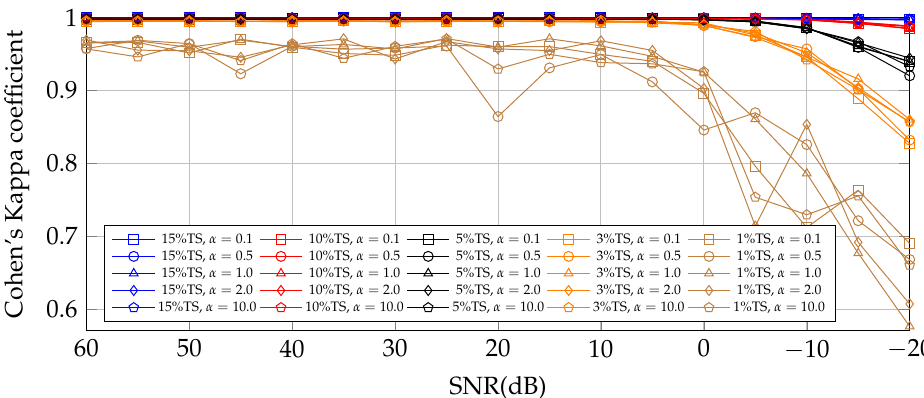
Figure 18. University of Pavia. Cohen’s Kappa coefficient obtained using 3DCNN DL model trained with 15%, 10%, 5%, 3%, and 1% of the samples of compressed UP HSI for different α values. α -values do not seem to influence on Cohen’s Kappa